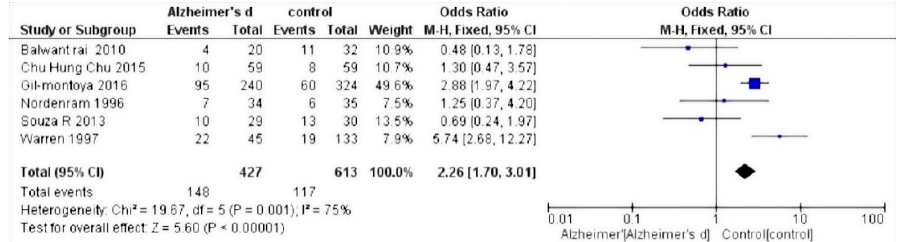
Figure 2. Forest plot of random effects models of the meta-analysis. Outcome: missing teeth.